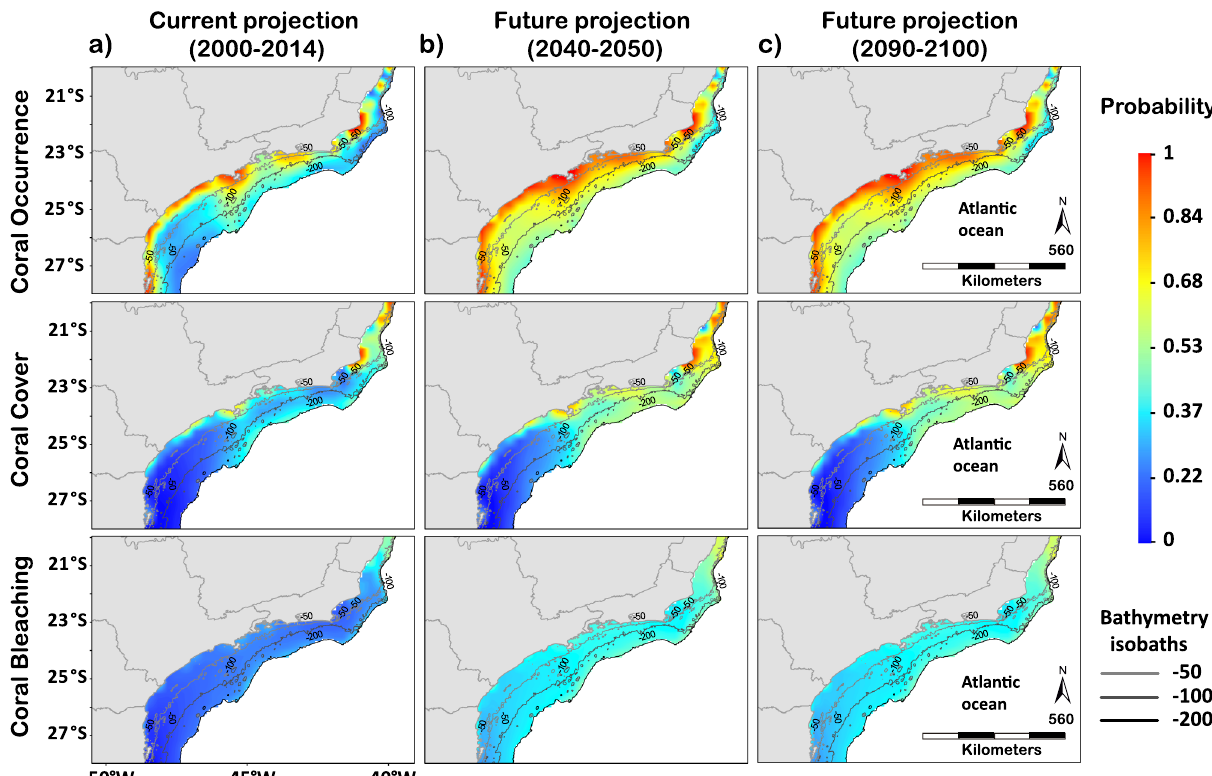
( b , c ) future probability projections of the transitioning zone from the tropical to the subtropical region with bathymetry isobaths represented by the different contours, from 50 to 200 m depth, which are specified in the legend (gln_batimetria_cprm_30 shapefiles, from (https:// geose rvicos. inde. gov. br/ geose rver/ web/). The blue- red scale bar represents absolute probability values. Maps created in ArcMap version 10.2 (https:// deskt op. arcgis. com/ en/